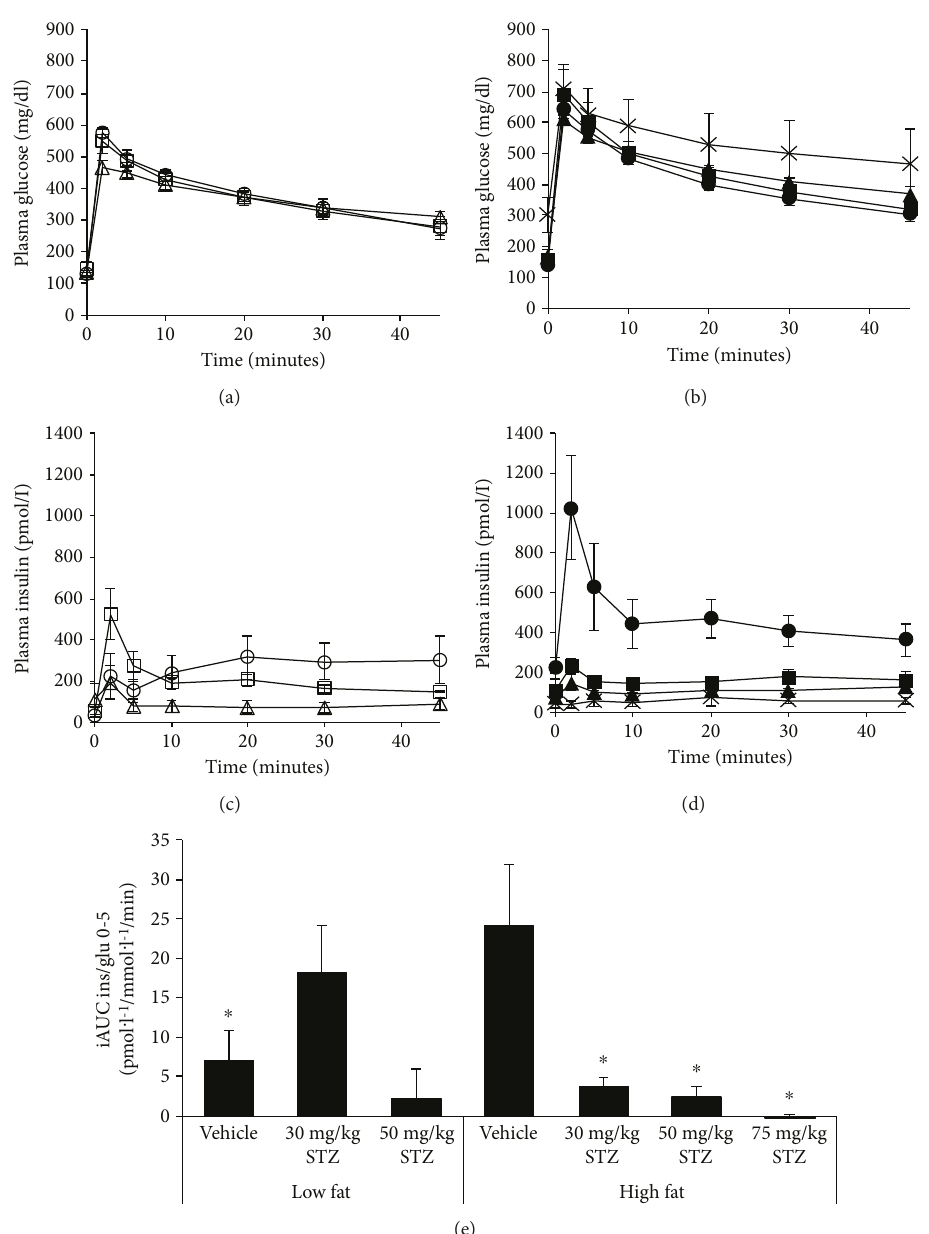
Figure 4: Plasma glucose (a, b) and insulin (c, d) levels during an IVGTT in low (a, c) and high (b, d) fat-fed mice treated with three consecutive once-daily doses of vehicle or 30, 50, or 75mg/kg STZ. (e) First-phase insulin responses during the IVGTT, computed as the ratio of incremental areas under the curve for insulin/glucose from 0 – 5 minutes in mice treated with three consecutive once- daily doses of vehicle or 30, 50, or 75mg/kg STZ. Treatment groups are denoted as follows: low fat — vehicle, open circles ( n = 4 ); low fat — 30mg/kg STZ, open squares ( n = 4 ); low fat — 50mg/kg STZ, open triangles ( n = 3 ); high fat — vehicle, closed circles ( n = 4 ); high fat — 30mg/kg STZ, closed squares ( n = 3 ); high fat — 50mg/kg STZ, closed triangles ( n = 6 ); and high fat — 75 mg/kg STZ, × ( n = 3 ). Data are means ± SEM . ∗ p < 0 05 versus high fat —